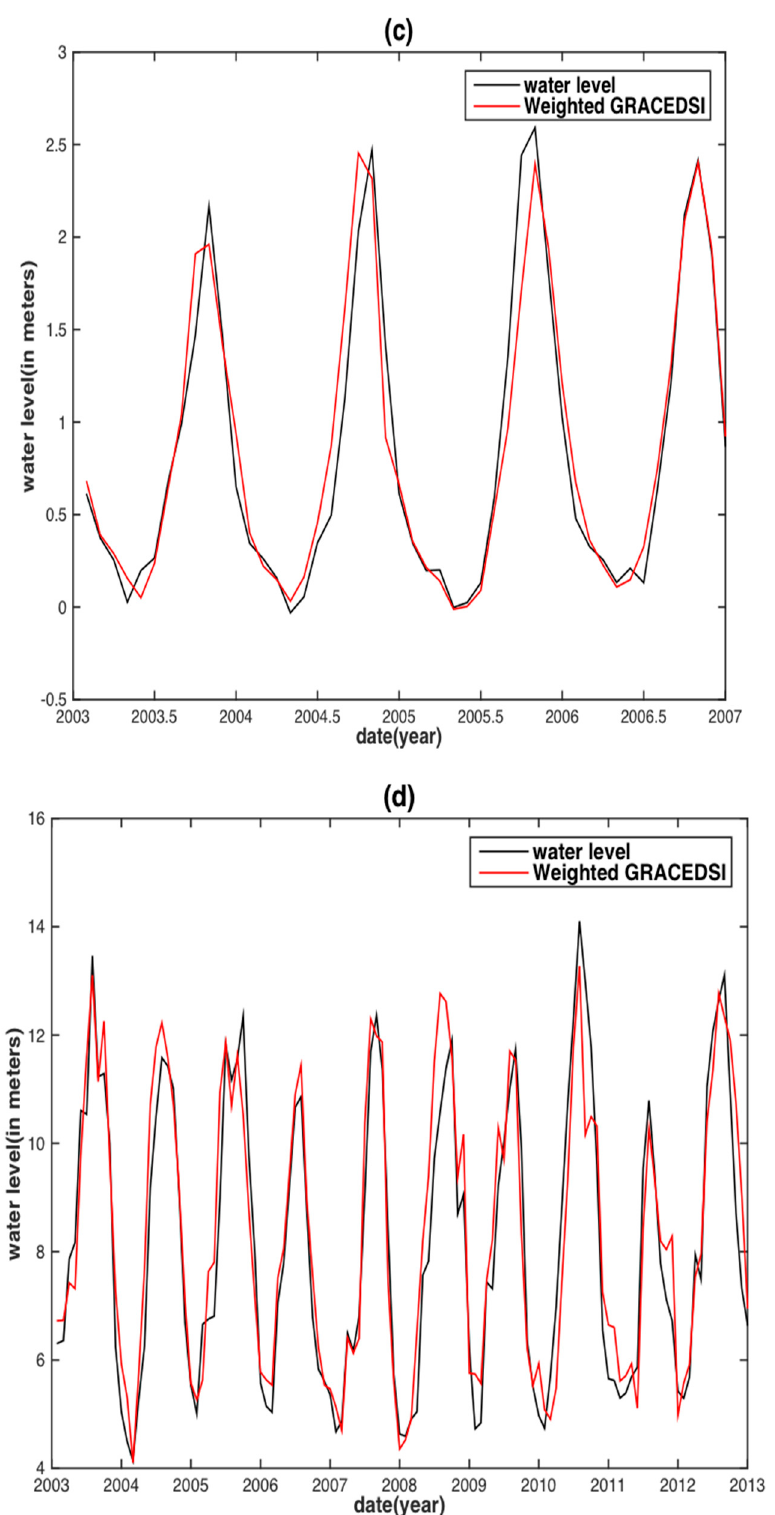
Figure 10. Water level reconstruction based on weight-averaged GRACE-derived TWS against the observed water level in the MRB ( a ) and the YRB ( b ) and weight-averaged GRACE-DSI reconstructed water level against the observed water level in the MRB ( c ) and the YRB ( d ).